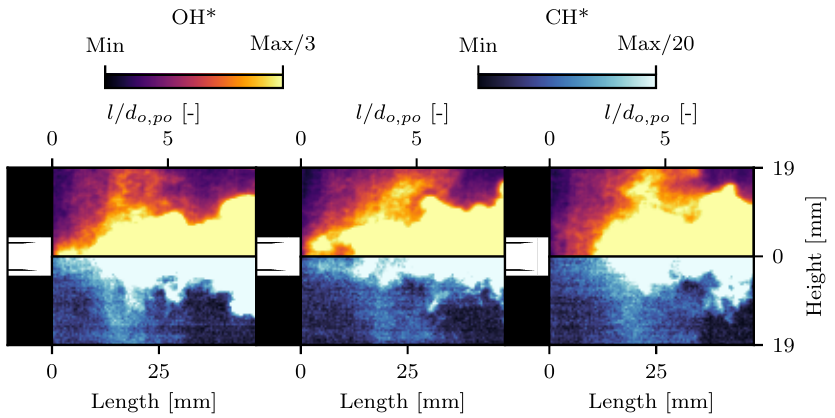
Figure 7 visualizes three instantaneous snapshots extracted from the interval of LP1.